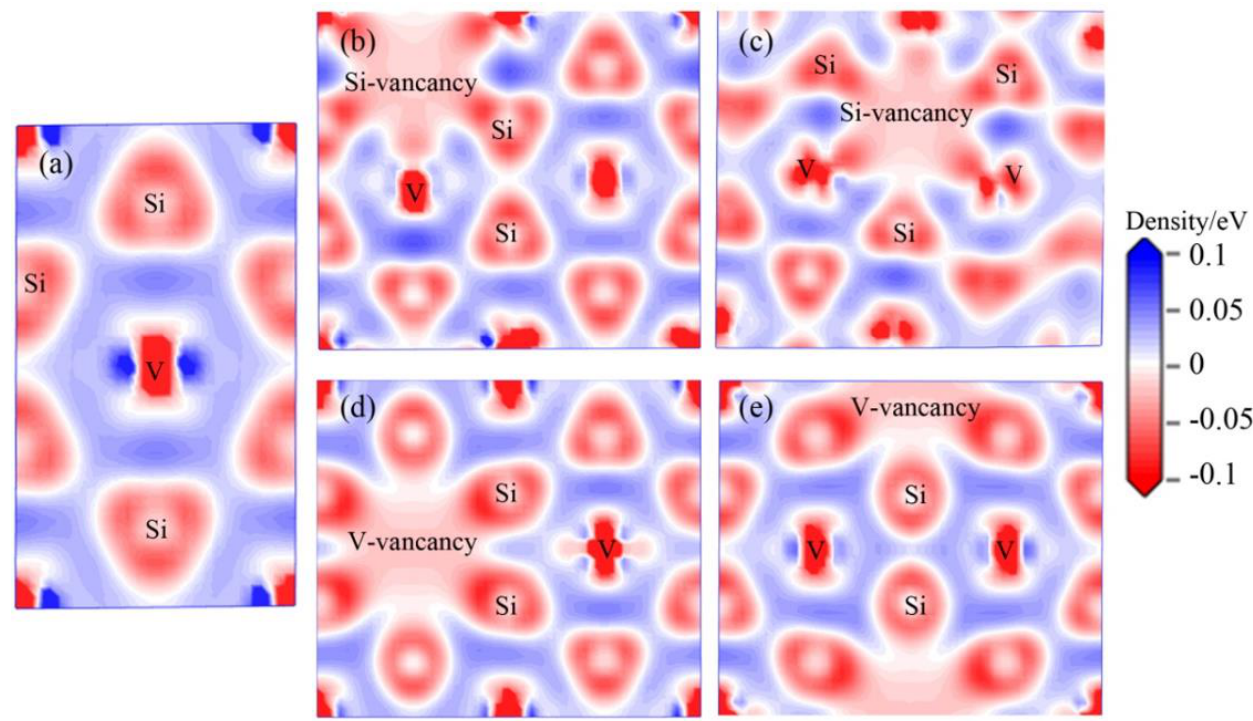
Figure 6. Electron density differences of C11 b -VSi 2 with various vacancies, ( a ) perfect C11 b -VSi 2 , ( b ) Si-va1, ( c ) Si-va2, ( d ) V-va1, and ( e ) V-va2, respectively.